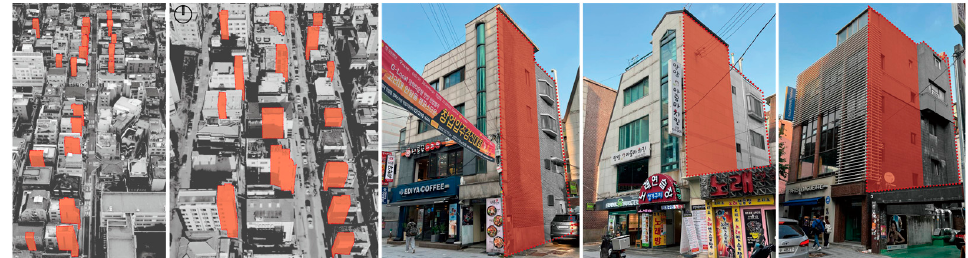
Figure 1. Examples of buildings in Seoul with ineffective use of south elevations for daylight.